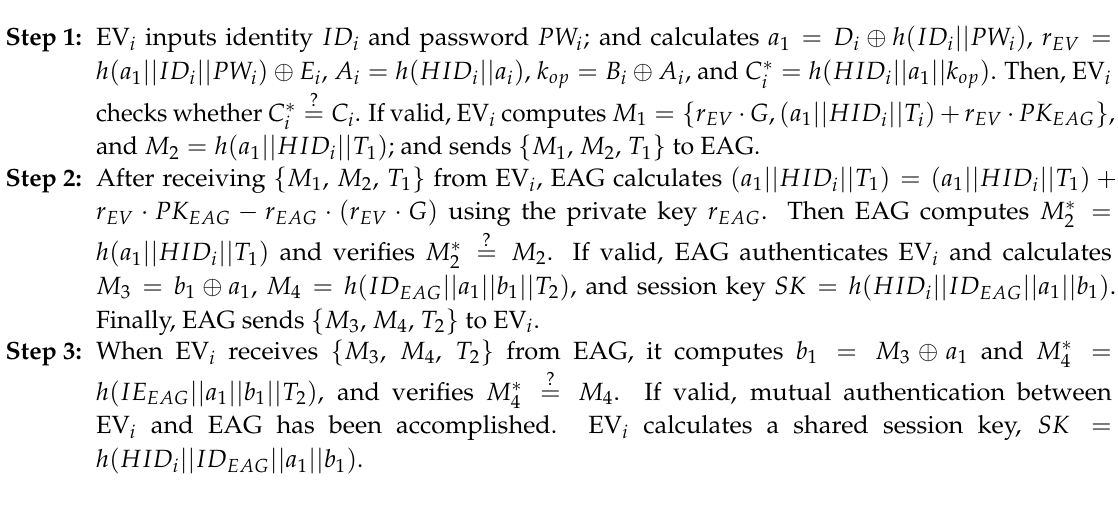
Figure 7. Authentication phase of proposed